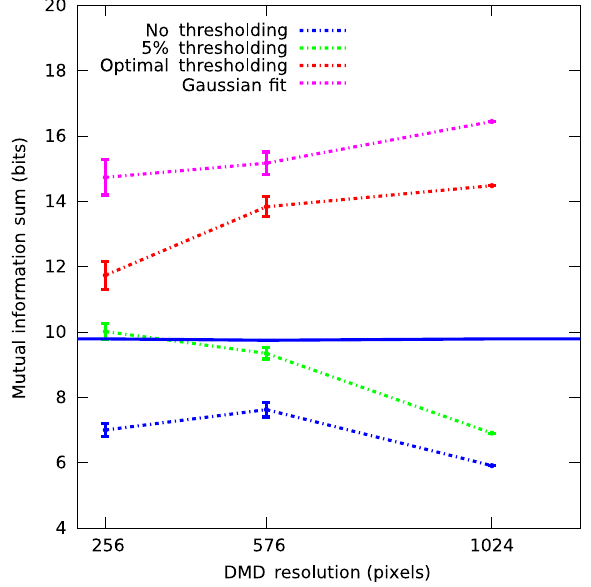
FIG. 7. The sum of position-position and momentum- momentum mutual information is presented as a function of detector resolution to demonstrate violation of an EPR steering inequality [Eq. (13)]. The solid line represents the threshold that must be exceeded to witness EPR steering. The error bars enclose 2 standard deviations from the expected uncertainty from simulations (not performed for n ¼ 1024 ). Because simu- lations systematically underestimate the mutual information, the values above the bound are